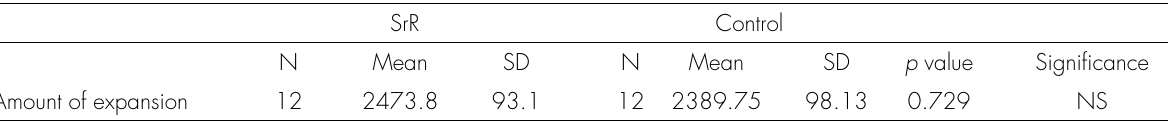
N: sample size; NS: non-significant; ***: p < 0.001 Table II. Comparison of biometric analysis for determination of the amount of dental expansion (µm).